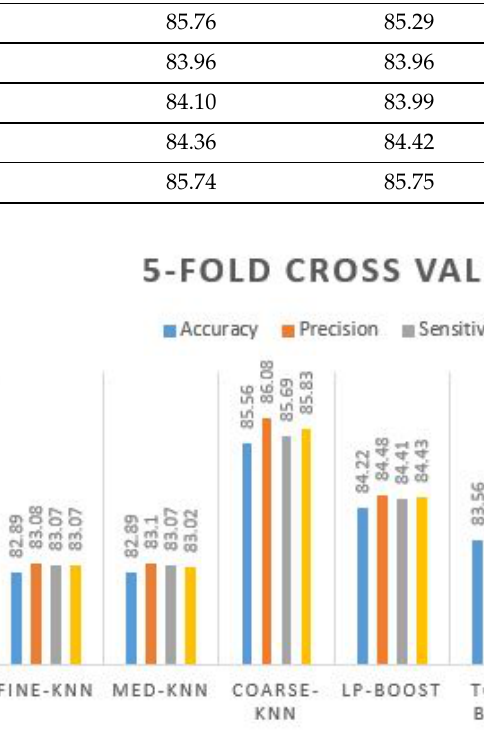
Figure 10. Prediction plot obtained using different ML classifiers on 10-fold cross validation. Table 13. Confusion matrix obtained using SVM on five-fold cross validation split.